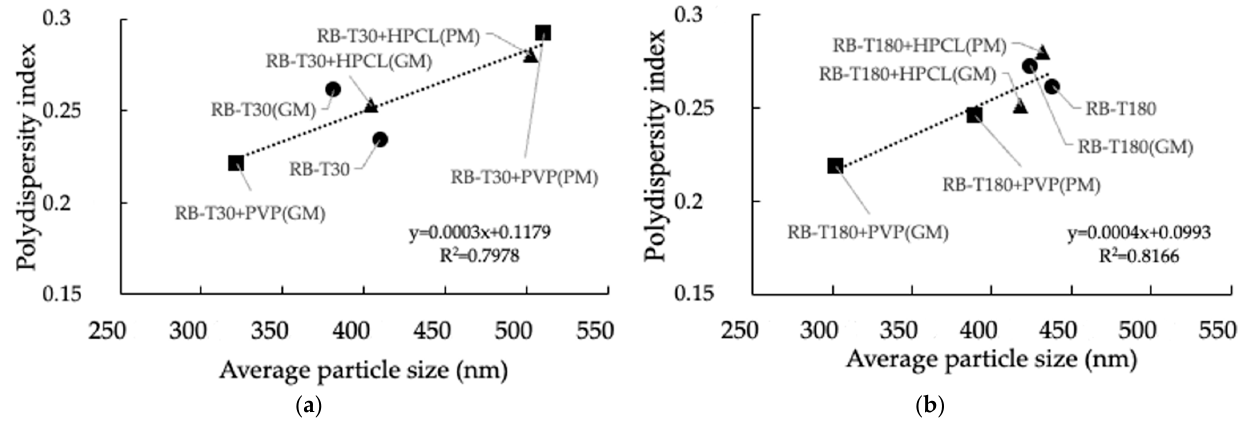
Figure 5. Polydispersity index to average particle size of various samples: ( a ) RB-T30 and ( b ) RB-T180. ball-milled samples [RB-T30(GM) and RB-T180(GM)], the GMs showed a smaller average